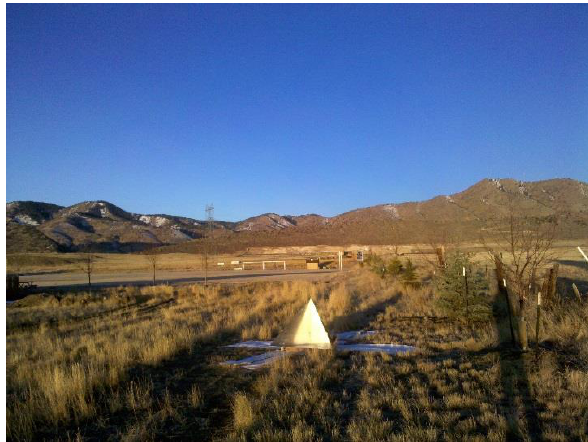
Figure 11. Large reflector (1 m by 1 m by 1.4 m)